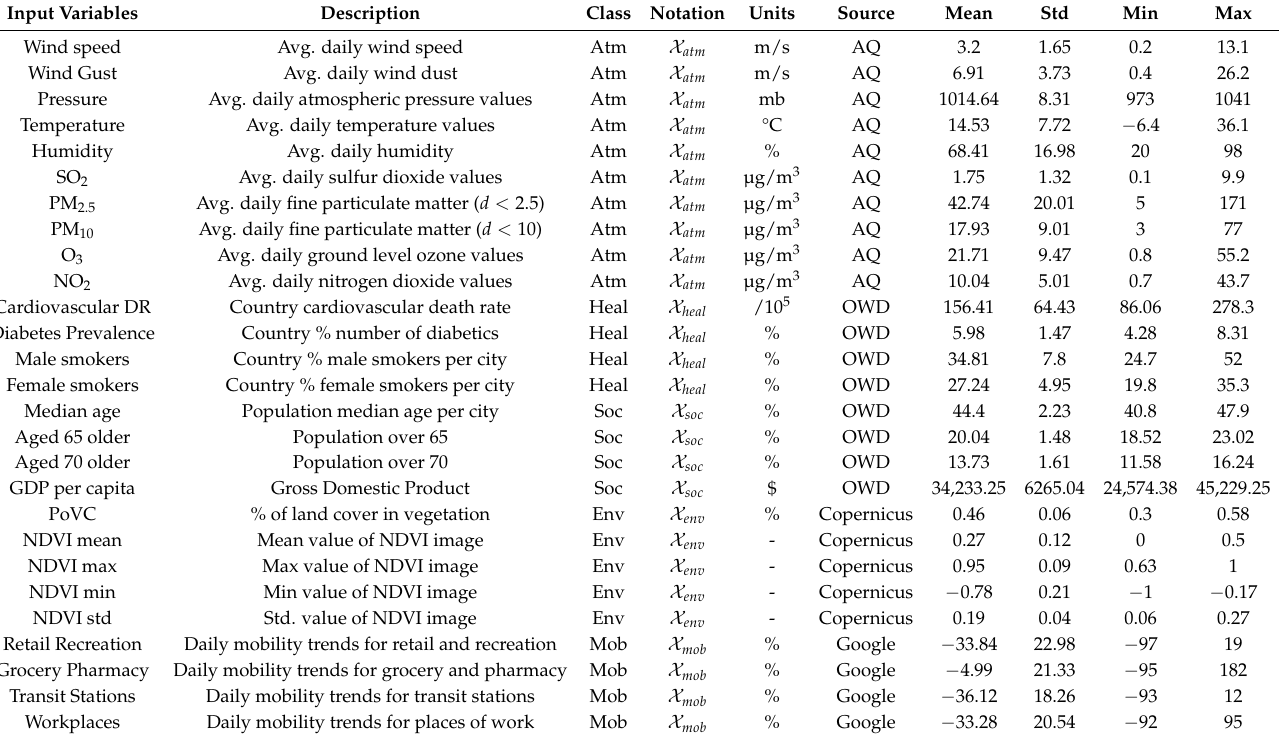
Table 1. Description of the data inputs into the proposed non-linear